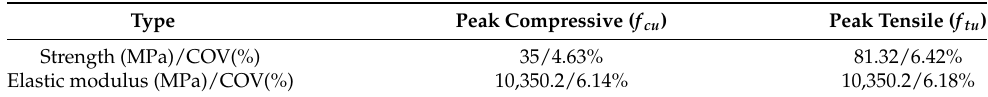
Table 4. Experimental data of